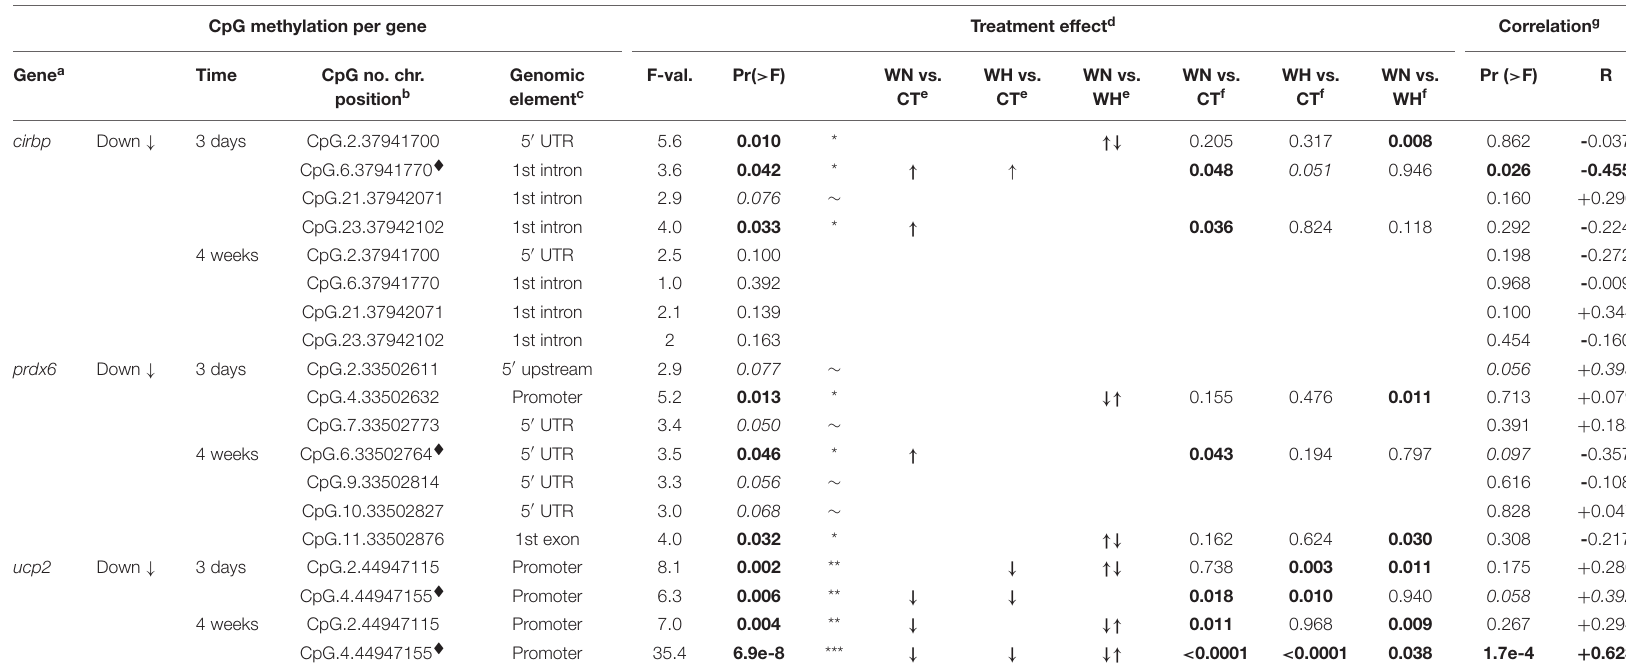
( Figure 2 ). d Linear mixed-effect models (lmer) were performed on CpG methylation values to assess the effects of the fixed factors “treatment” (CT, Control; WN, Warm & Normoxic; WH, Warm & Hypoxic) and “sex” (Female vs. Male), and “tank” was included as a random term. Significant p-values are marked in bold letters (p < 0.001 ∗∗∗ , p < 0.01 ∗∗ , p < 0.05 ∗ ) and trends in italics (0.05 < p < 0.10) with an “ ∼ ” symbol. The complete results for all 94 CpGs are given in Supplementary Table S2 . e The arrows indicate the direction of CpG methylation responses ( ↑ hyper-methylated, ↓ hypo-methylated) and represent the results of least square means (lsmeans) post-hoc tests to differentiate between treatment groups. Bold arrows illustrate the direction of significant differences between CT vs. WN, CT vs. WH, and WN vs. WH groups (p < 0.001 ∗∗∗ , p < 0.01 ∗∗ , p < 0.05 ∗ ), while narrow arrows indicate trends (0.05 < p < 0.10) (see Supplementary Table S2 ). f The p-values of the lsmeans post-hoc test used for differentiating between CT, WN vs. WH groups (see Supplementary Table S2 ). g Spearman’s rank correlation coefficients (R) and corresponding p-values to estimate the overall association between CpG methylation (%) and transcript expression (RQ) in the treatment groups (see Supplementary Table S2 ). (cid:7) The diamond symbol indicates CpGs with significant changes in methylation that correlated with transcript